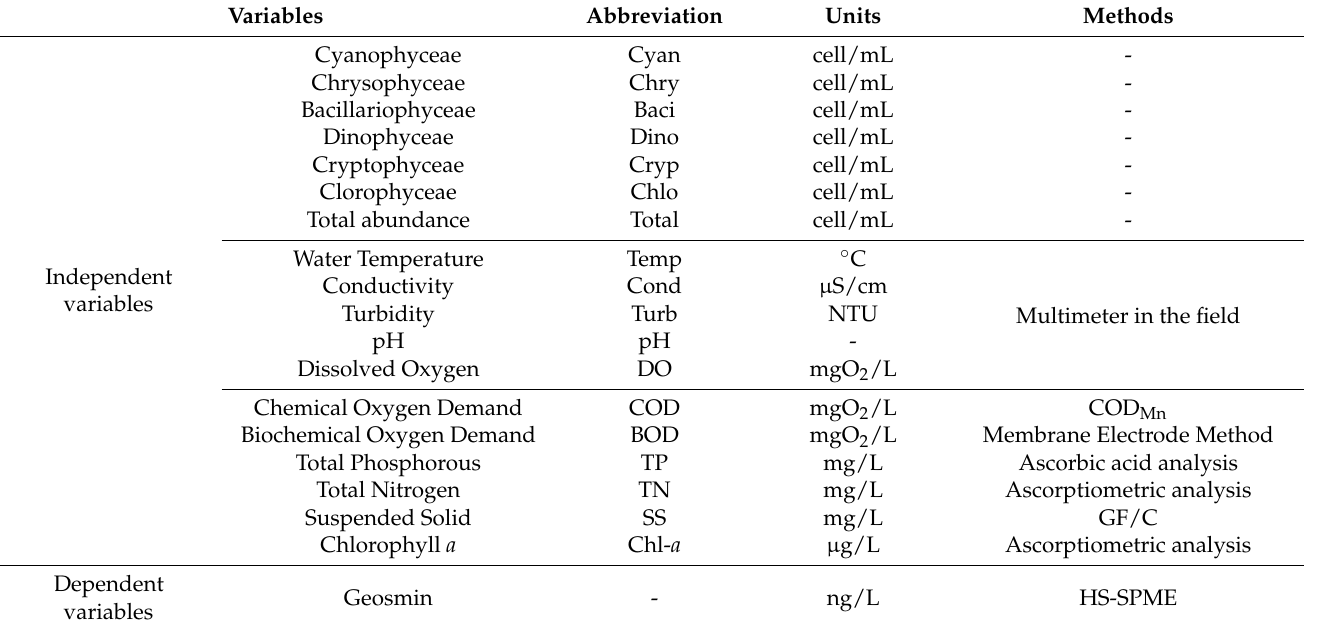
Table 2. Summary of 19 variables used in the prediction model (units, methods of measurement and abbreviations). Variables